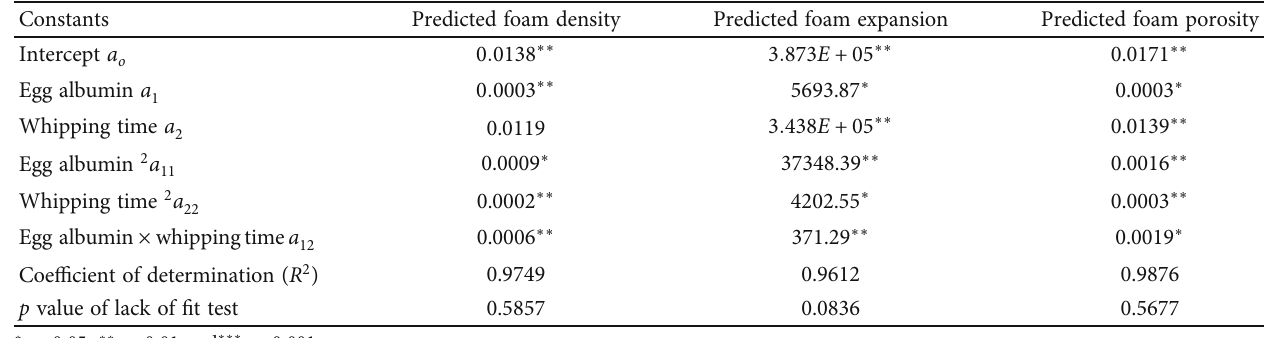
= egg albumin (%) and x = whipping time (min). 1 2